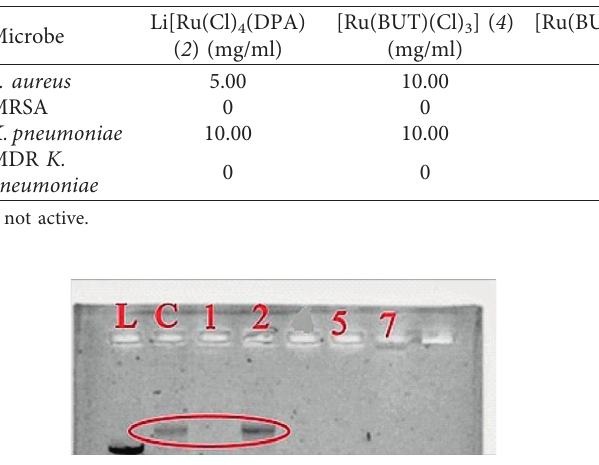
Table 5: MIC of all active compounds.